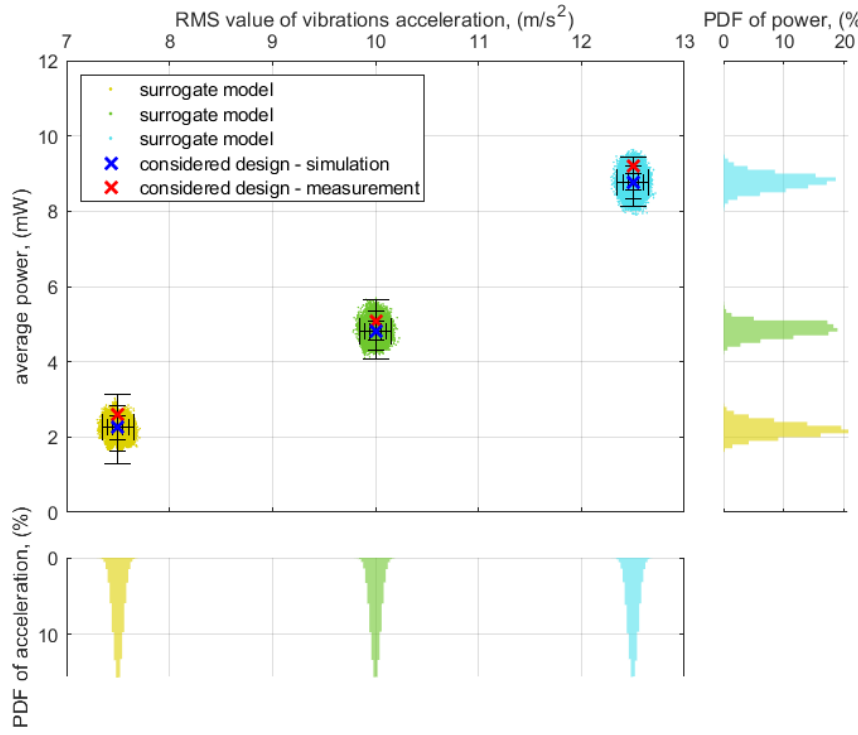
Figure 12. Average power for 10 5 design points with probability density functions (PDF) and errorbars denoting confidence levels considering only the deviations of material parameters.